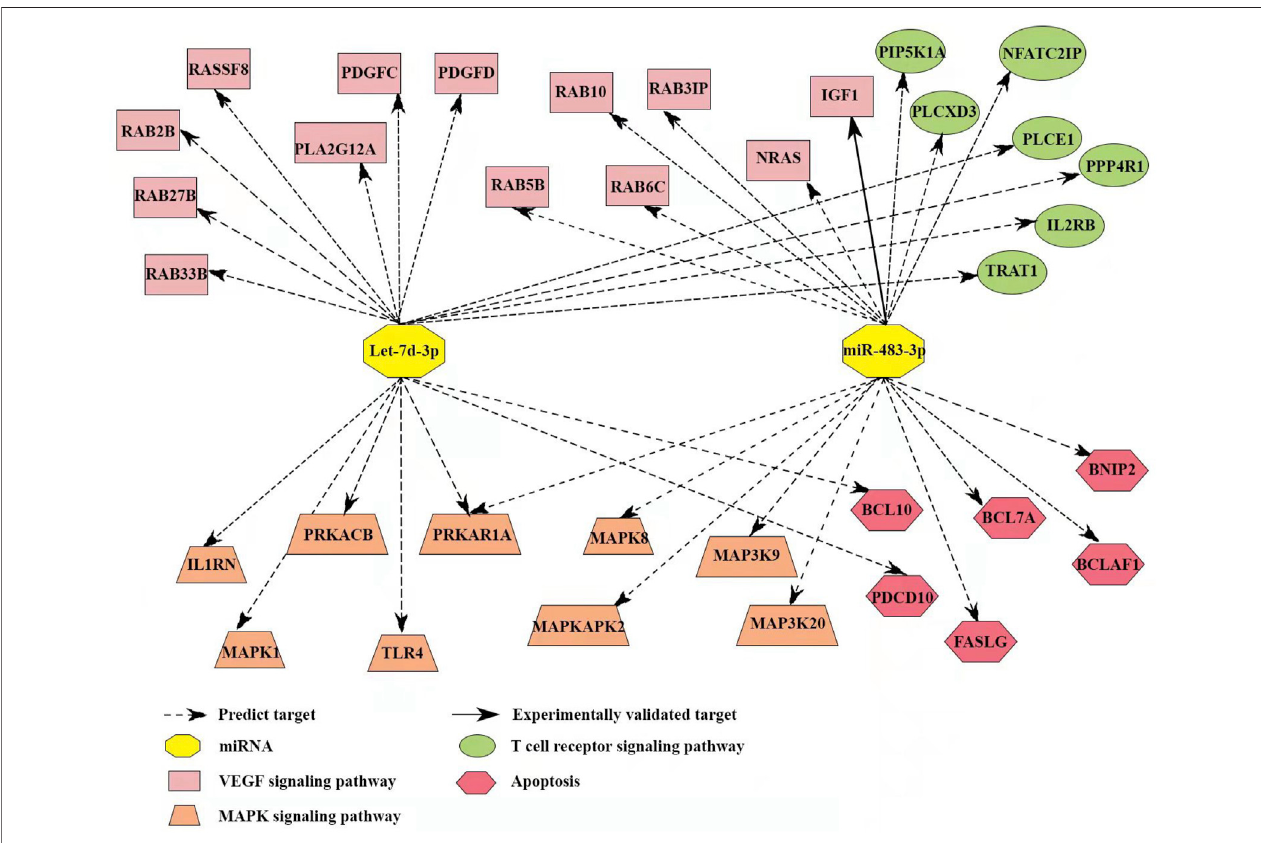
FIGURE 7 | Target gene network of miR-483-3p and let-7d-3p in pathways with relevance to immune and endothelial dysfunctions during sepsis. The network contained 35 targeted genes and was constructed using reported and predicted human miRNA:mRNA interactions from the TargetScan and miRDB databases.